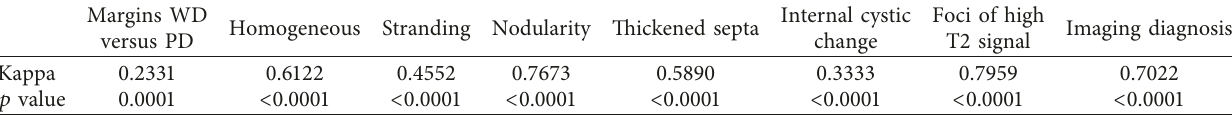
Table 2: Interobserver reliability amongst four expert readers of MRI for commonly reported imaging characteristics.